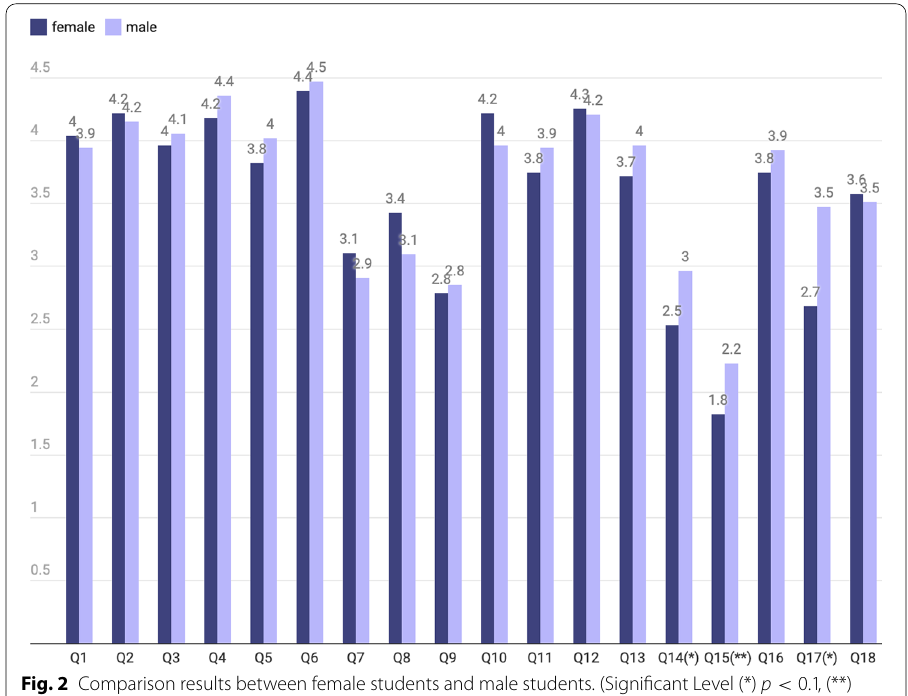
Fig. 2 Comparison results between female students and male students. (Significant Level (*) p < 0.1 , (**) p < 0.05